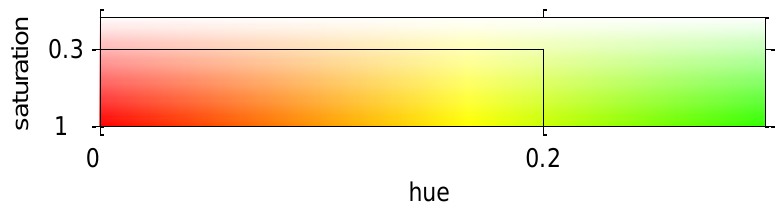
Figure 11. Colors included imposing the thresholds to HSV values (saturation is